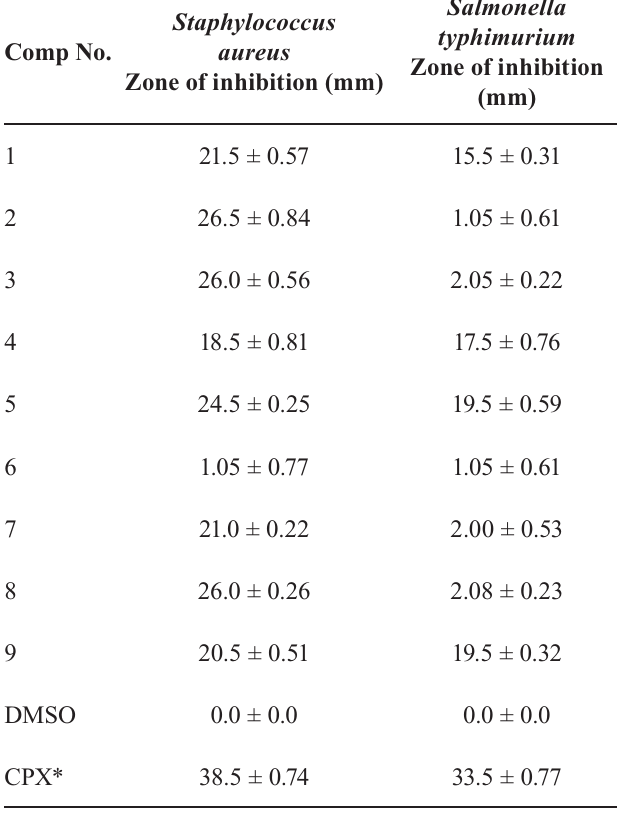
TABLE II - Antibacterial bioassay screening of investigated compounds on two selected bacterial strains